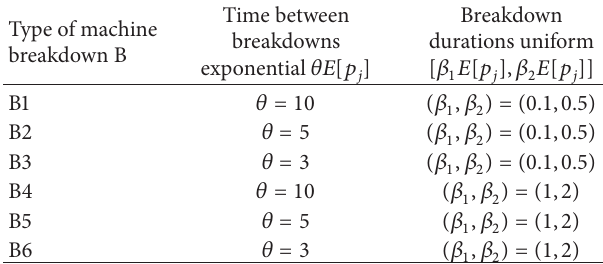
Table 2: Type of machine breakdown.